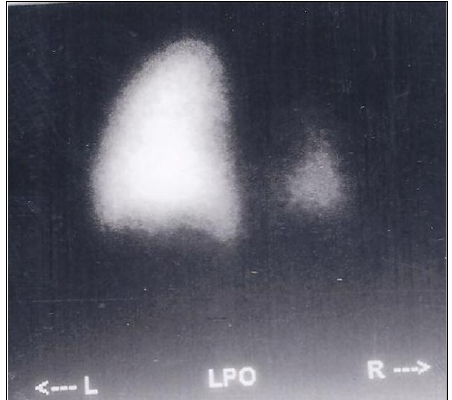
Figure 1: Ventilation perfusion scan with normal left lung and hypoplastic lower lobe of right